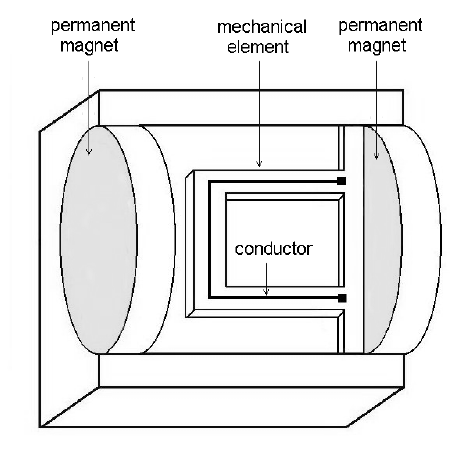
Figure 17. Proposition for a